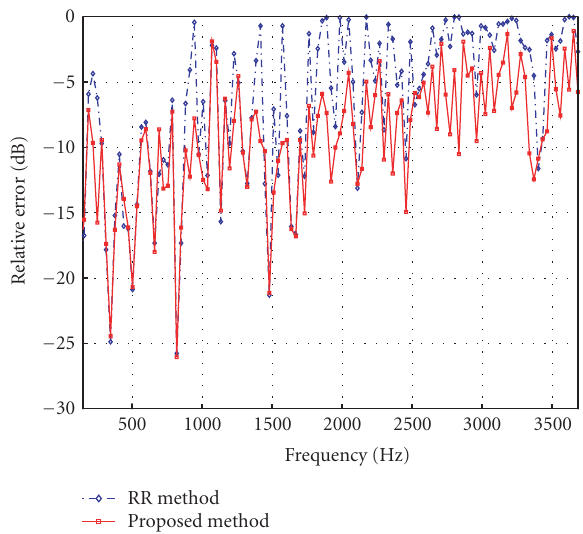
Figure 2: Comparison of the relative estimation error between the RR method and the proposed method at 0dB input SNR.